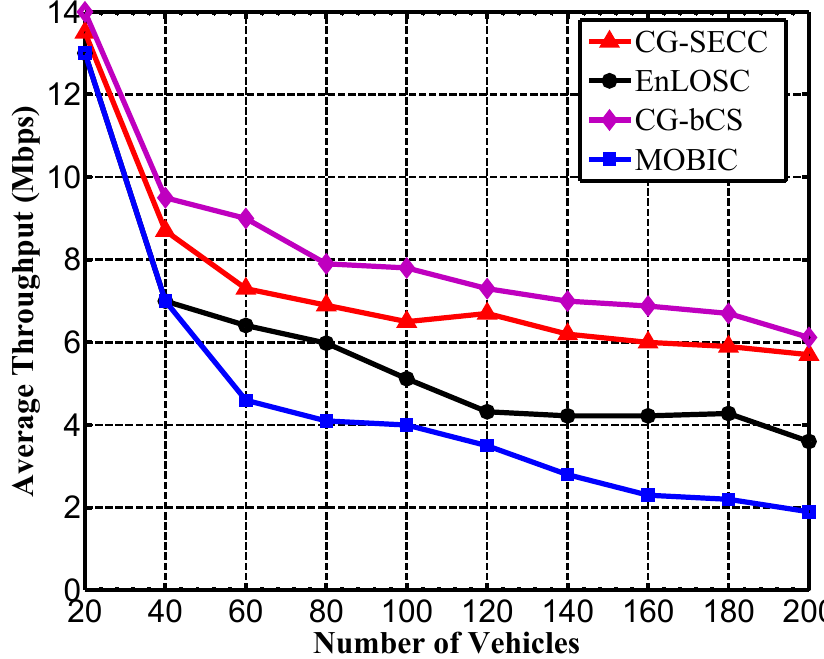
Figure 6. Analysis of the